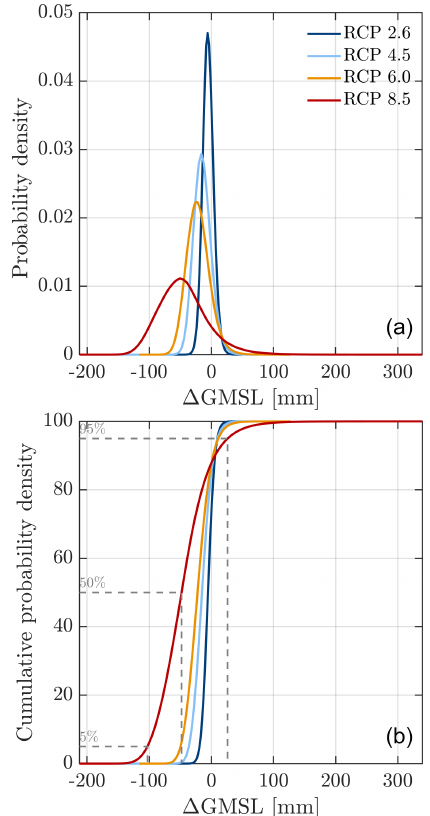
Figure 5. Probability density (a) and cumulative probability den- sity (b) for projections of change in global mean sea level ( (cid:49) GMSL) in millimetres by the year 2300 under four RCP emis- sions scenarios. Dashed lines show the 5th, 50th, and 95th per- centiles for the highest emission scenario